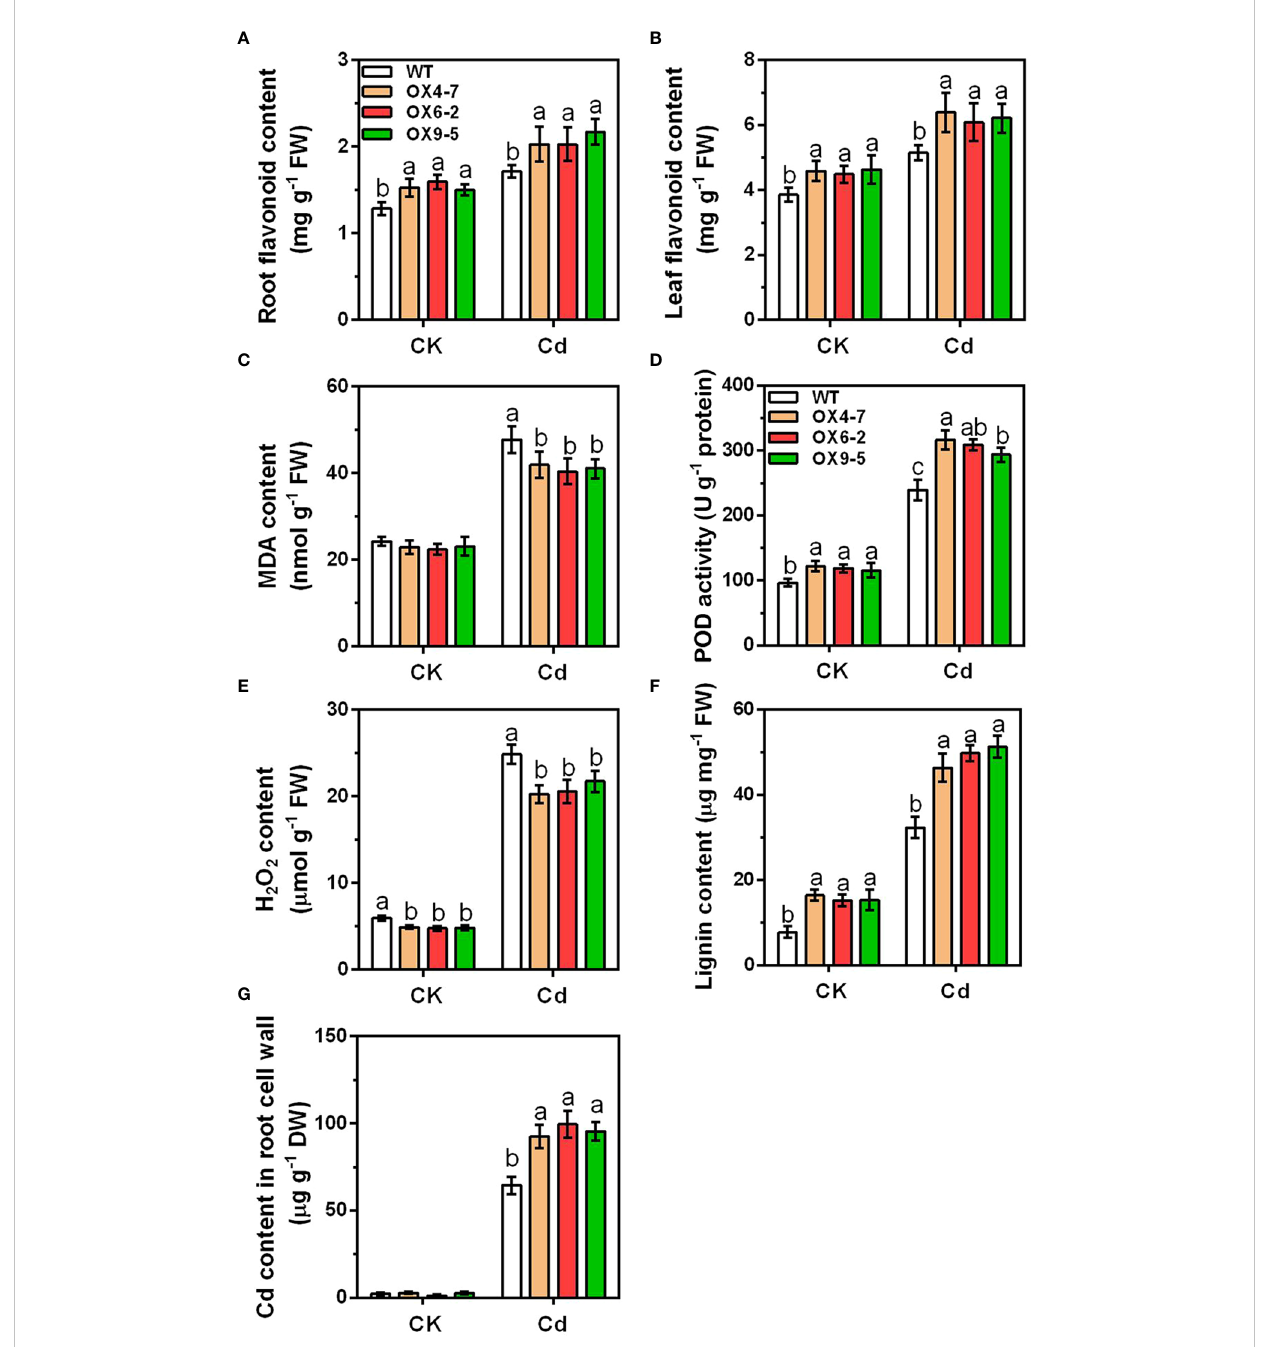
FIGURE 6 Physiological phenotype analysis of WT and transgenic soybean plants. Root fl avonoid content (A) , leaf fl avonoid content (B) , MDA content (C) , POD activity (D) , H 2 O 2 content (E) , lignin content (F) , and the root cell wall Cd content (G) were detected under normal or Cd-treated (0.40 mg kg -1 ) conditions. Data are expressed as mean ± SD ( n = 3). Different letters indicate statistical signi fi cance determined by one-way analysis of variance and Duncan ’ s test ( P ≤